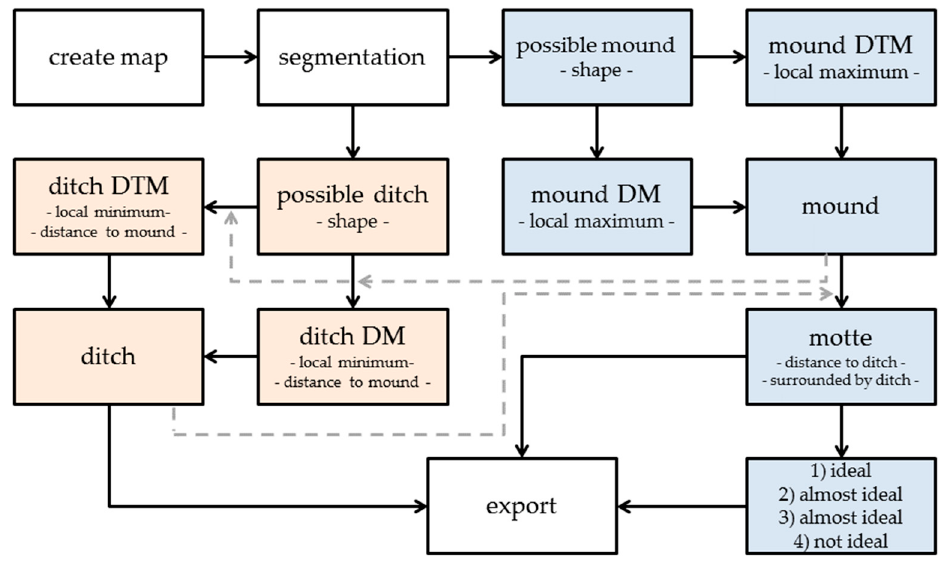
Figure 11. Overview of the workflow in eCognition for the detection of Motte-and-Bailey castles. Table 4. Overview of the classes that represent the mottes by their degree of erosion. Class